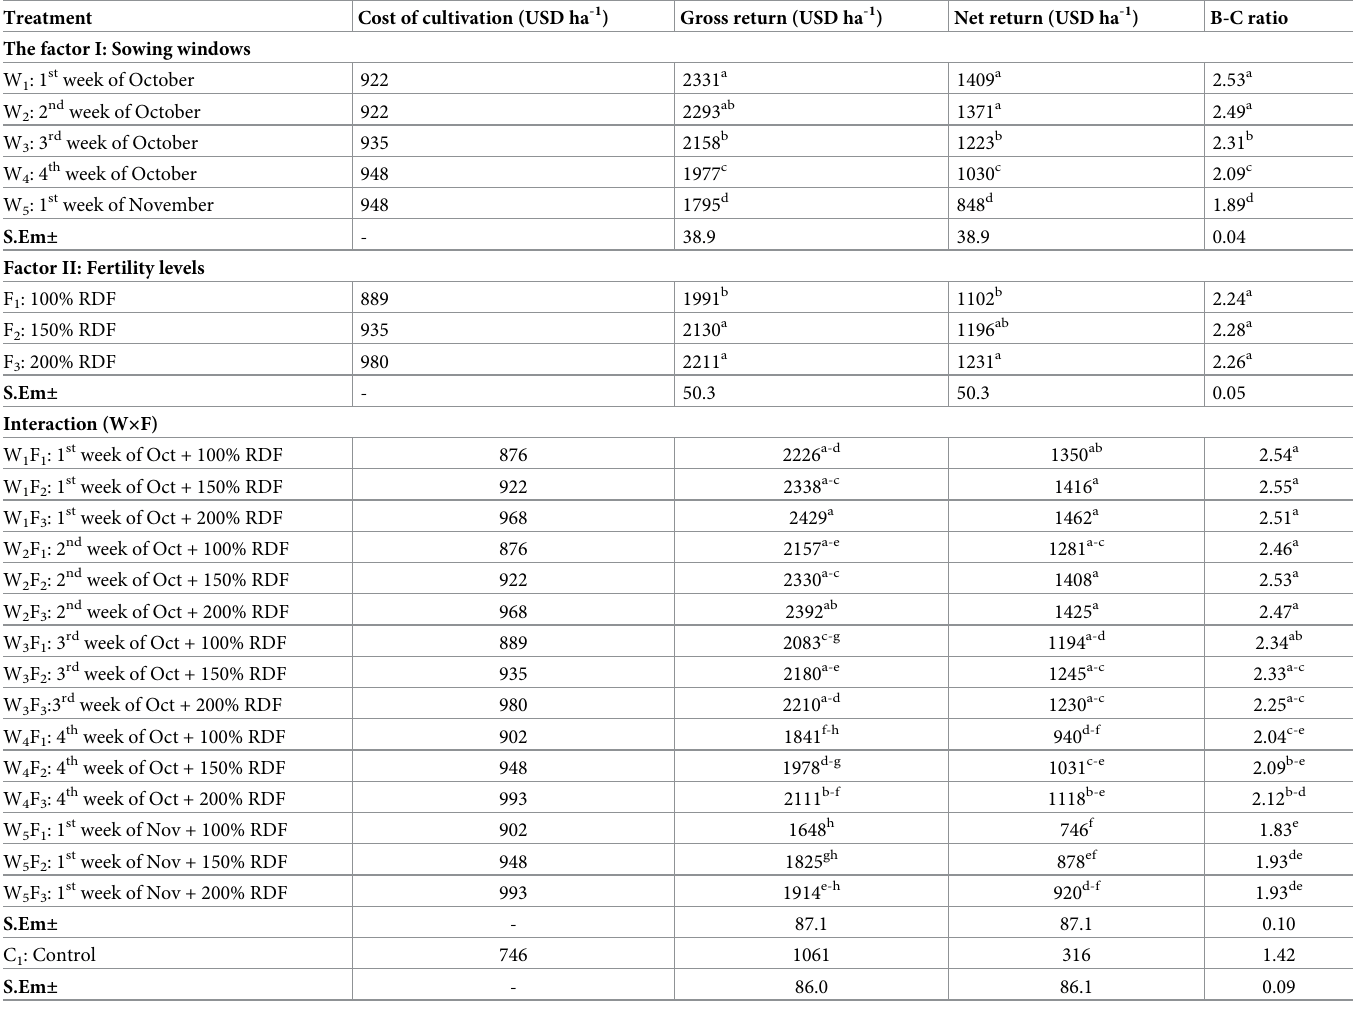
Table 6. Economics of winter maize as influenced by sowing windows and fertility levels.